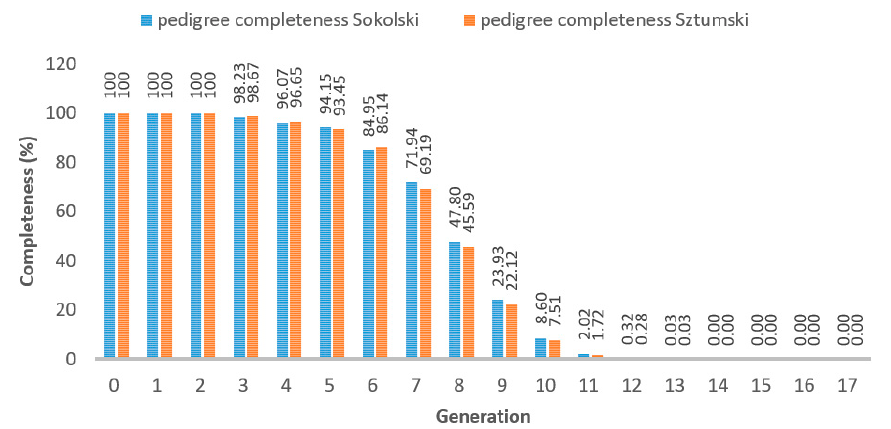
Figure 3. Pedigree completeness (%) in analyzed Sztumski and Sokólski cold ‐ blooded horses, based on pedigree information.